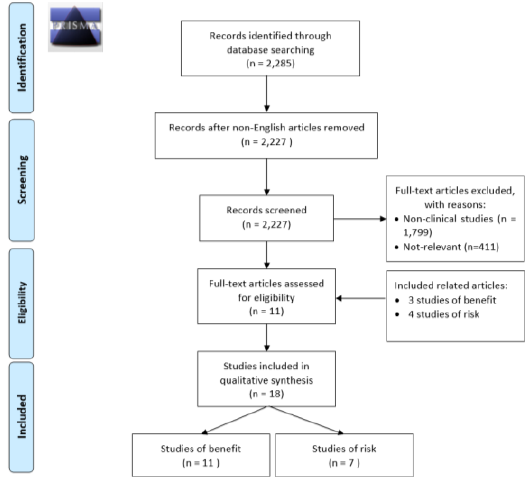
Figure. 1. PRISMA